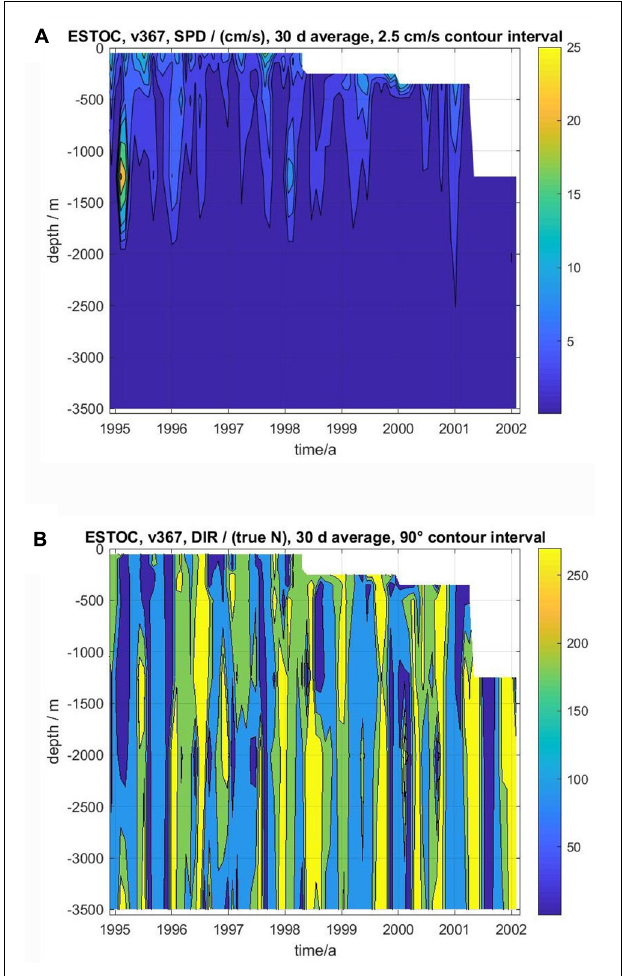
FIGURE 4 | Vector averaged (30 days) current speeds ( A , cm s − 1 ) and directions ( B , degree direction true north) at ESTOC from November 1994 to February 2002. Contour interval for current speed is 2.5 cm/s between 0 and 10 cm s − 1 , and 10 cm s − 1 above. For direction, contour interval is 90 degrees between 0 ◦ and 360 ◦ , thus resolving average current directions toward the four sectors North-East NE (dark blue), SE (light blue), SW (green), and NW (yellow). Note that current meter data at ESTOC were measured only between 1994 and 2002, thus covering only part of the period of the trap measurements